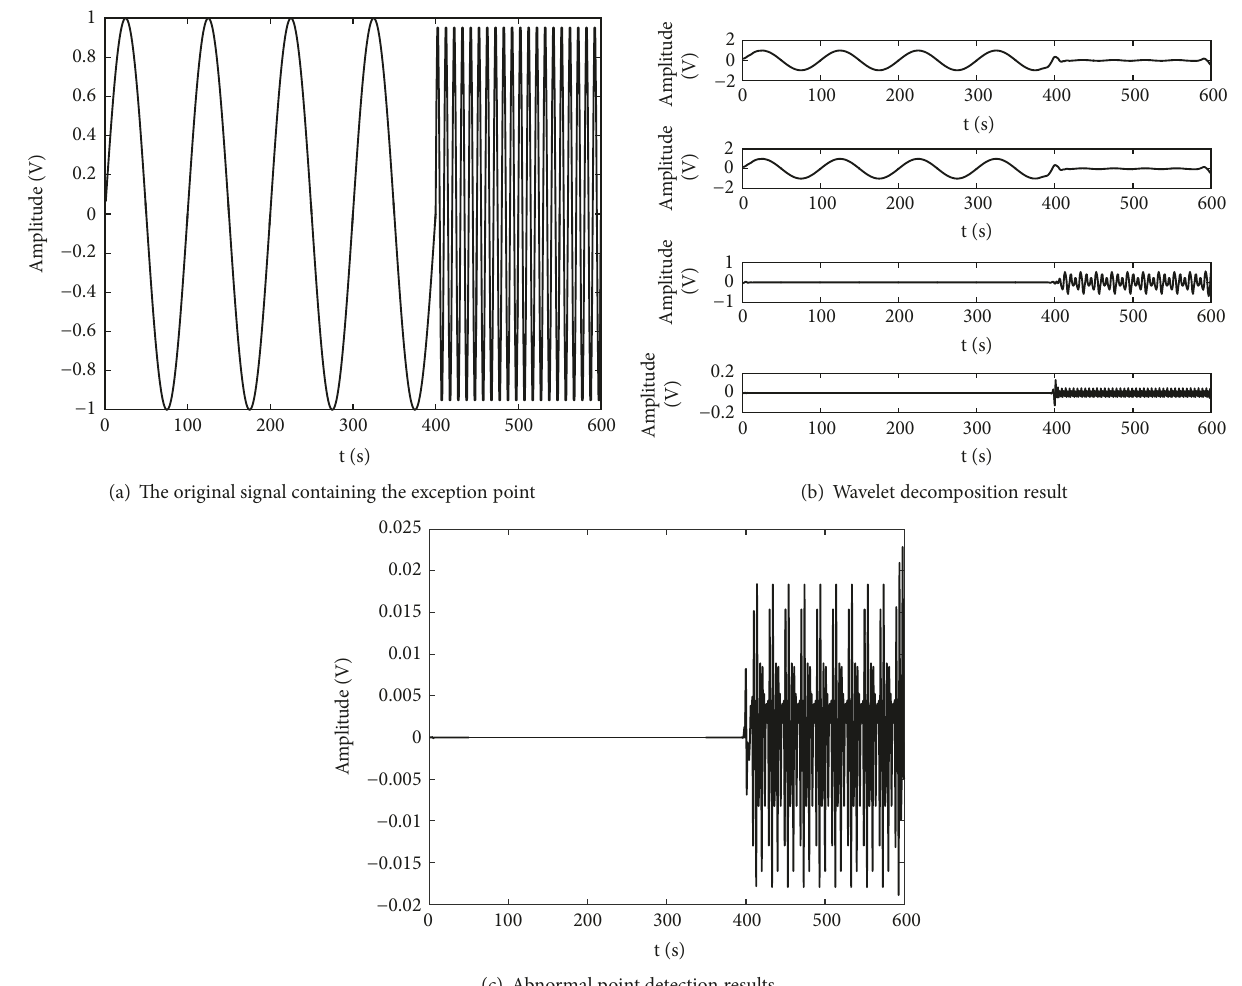
Figure 7: Simulation result of cooperative anomaly extraction.